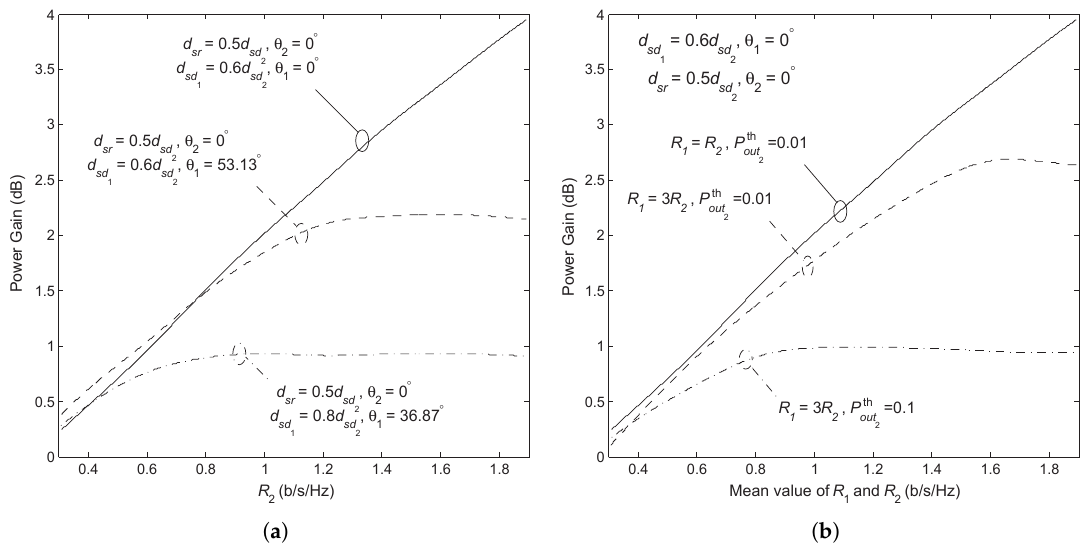
= out ,1 has the same transmission rate 2 , and lower transmission rate and larger outage 1